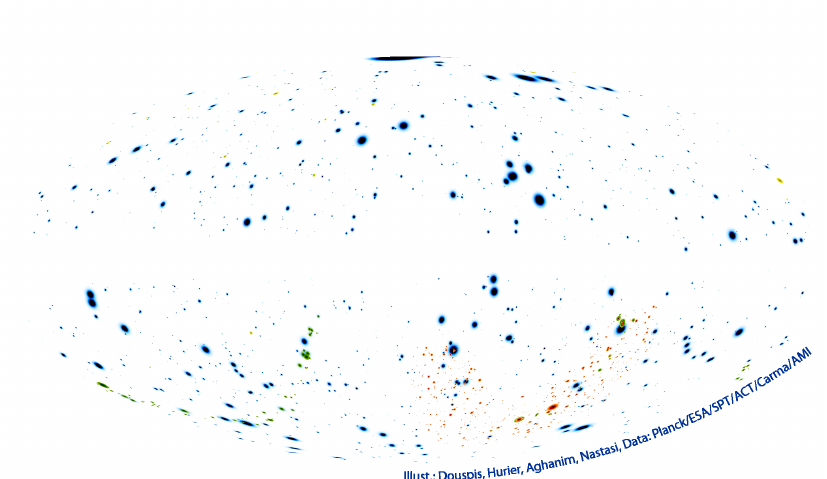
Figure 2. Distribution over the sky in galactic gnomonic projection of the ACT (green), SPT (red), Planck (blue) clusters . Credits: Doupis et al., The SZ Cluster Database project, http: // szcluster-db.ias.u- psud.fr